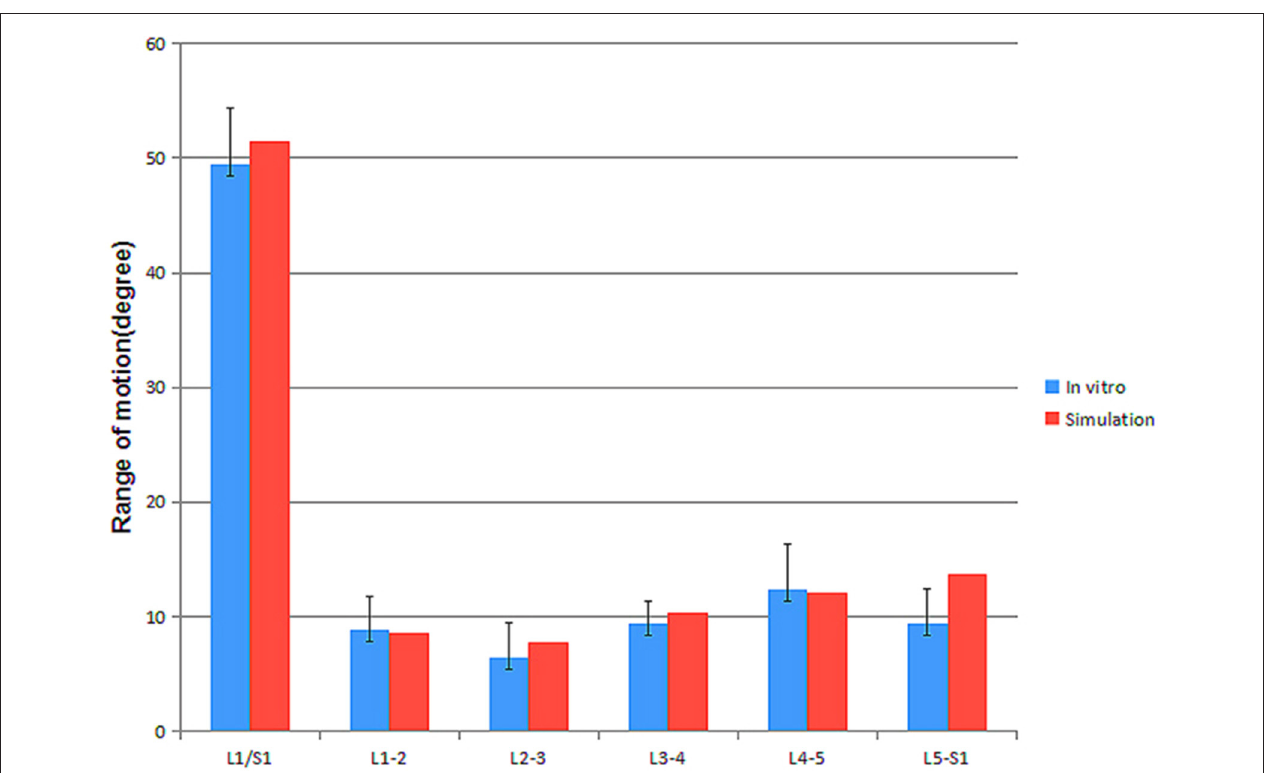
FIGURE 3 | FEM simulation compared to the in vitro experiments data.